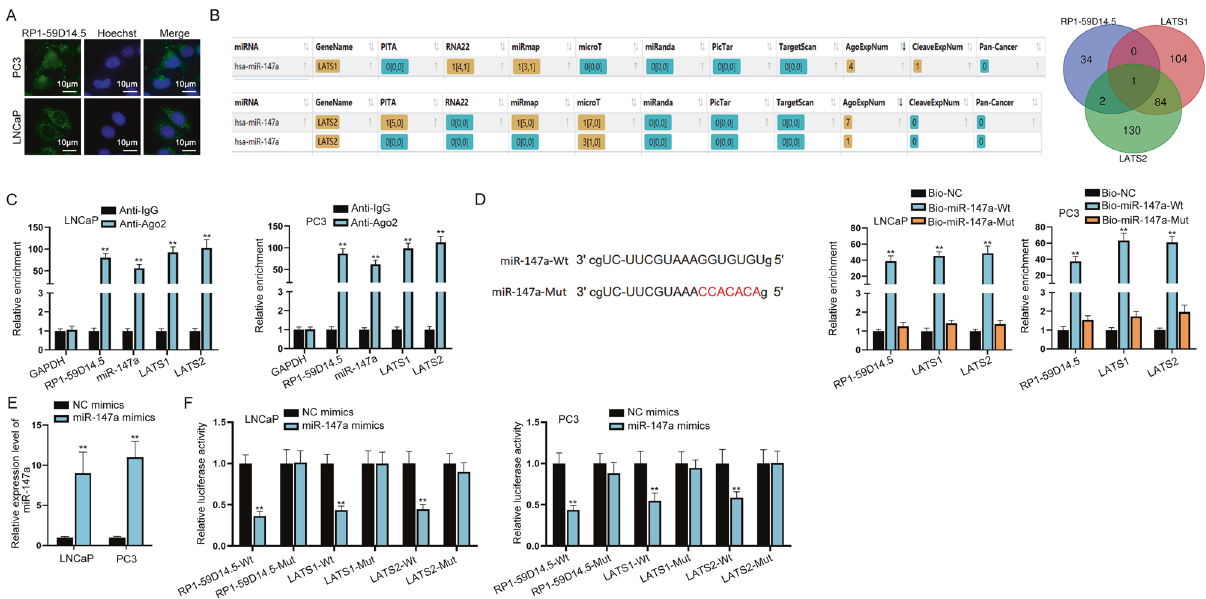
Fig. 3 RP1-59D14.5 targets the miR-147a/LATS1/2 axis in PCa cells. A FISH assays determined the subcellular location of RP1-59D14.5 in PCa cells. Scale bar = 10 μ m. B The starBase prediction of putative miRNAs of LATS1/2. Venn diagram illustrated a common miRNA of RP1-59D14.5 and LATS1/2. C RIP assays were performed to detect the association of RP1-59D14.5, miR-147a, and LATS1/2 with Ago2-RISC. D The sequence of miR-147a-Wt (wild type miR-147a) and miR-147a-Mut (mutant miR-147a) were shown. RNA pull down assays detected the enrichment of RP1-59D14.5 and LATS1/2. E RT-qPCR examined miR-147a expression in PCa cells transfected with miR-147a mimics. F Luciferase reporter assays detected the luciferase activity of wild-type or mutant-type RP1-59D14.5 and LATS1/2. ** P <